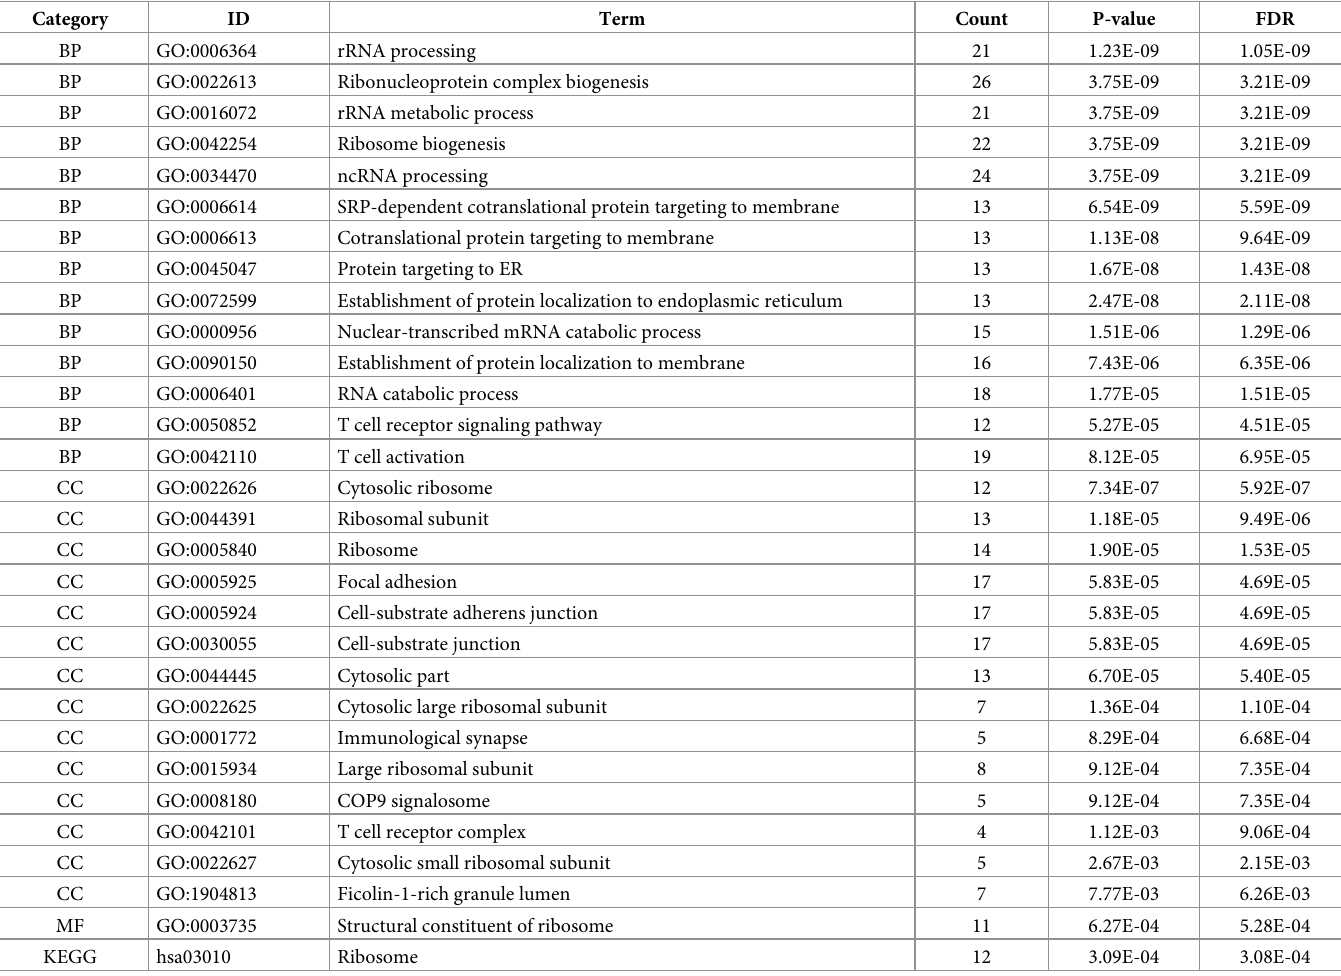
Table 3. The top 30 functional enrichment terms enriched for the hub genes identified in this study.